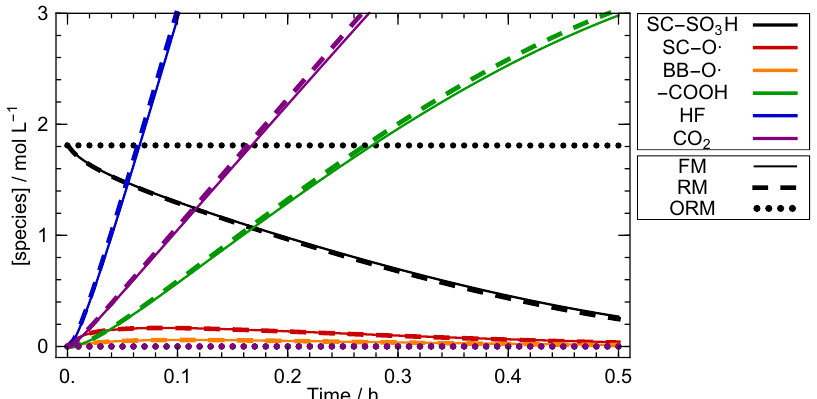
Figure 5. Comparison between results of the FM, the RM, and the over-reduced model (ORM) at T = 90 ◦ C and high concentrations of iron ions ([Fe 3+ ] + [Fe 2+ ] = 10 5 ppm) and hydrogen peroxide ([H for which a significant discrepancy ( MSE = 10 − 2 ) is calculated between the FM and the RM. Even though the differences between the results of both models are clearly visible, the results are very similar with the same trends of concentration